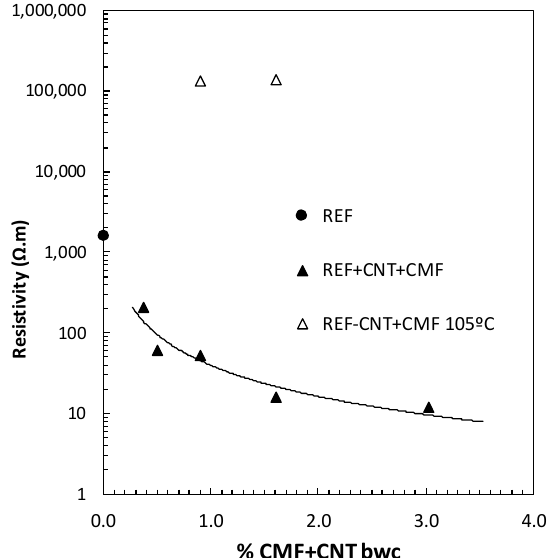
Figure 7. Electrical resistivity changes of SCC with several CNT and CMF contents at 25 and 105 °C.